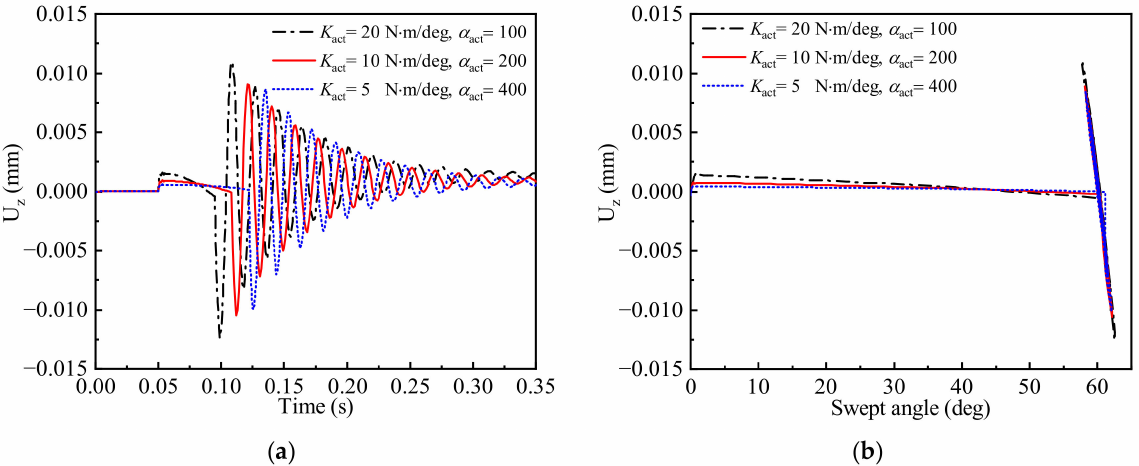
Figure 16. Transient responses of the displacement in z direction at the wing tip. ( a ) Displacement vs. time. ( b ) Displacement vs. sweep